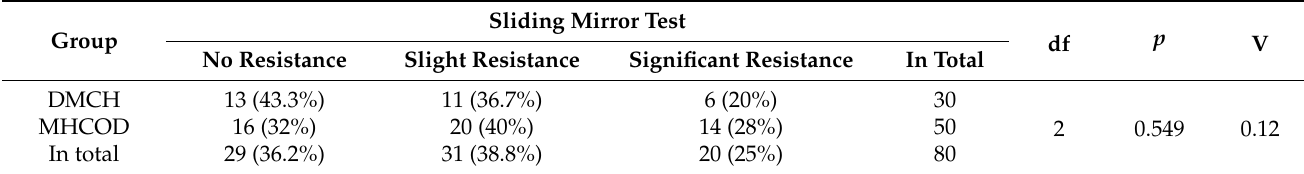
Table 12. The results of sliding mirror test in both groups.